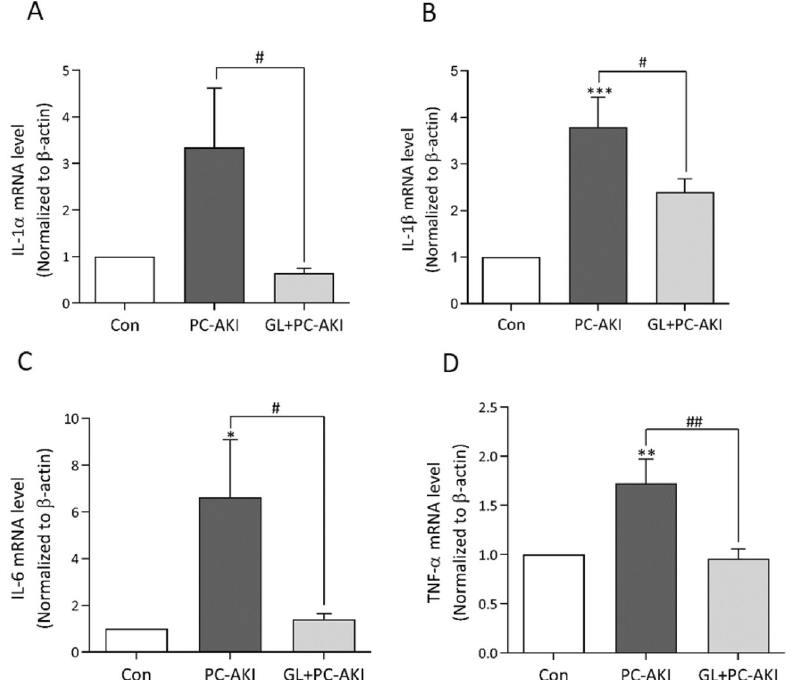
Figure 3. Effect of glycyrrhizin on the mRNA expression of pro-inflammatory cytokines. (A-D) Relative expressions of IL-1α, IL-1β, IL-6 and TNF-α mRNA were analyzed using RT-PCR. All pro-inflammatory cytokines were higher in PC-AKI compared to the controls with/without statistical significance, whereas they were lower in the glycyrrhizin pretreatment group. Results were expressed as means ± SEMs. N = 8 for each group. Statistical significance: * P < 0.05, ** P < 0.01 and *** P < 0.001 Con vs PC-AKI. # P < 0.05 and ## P <